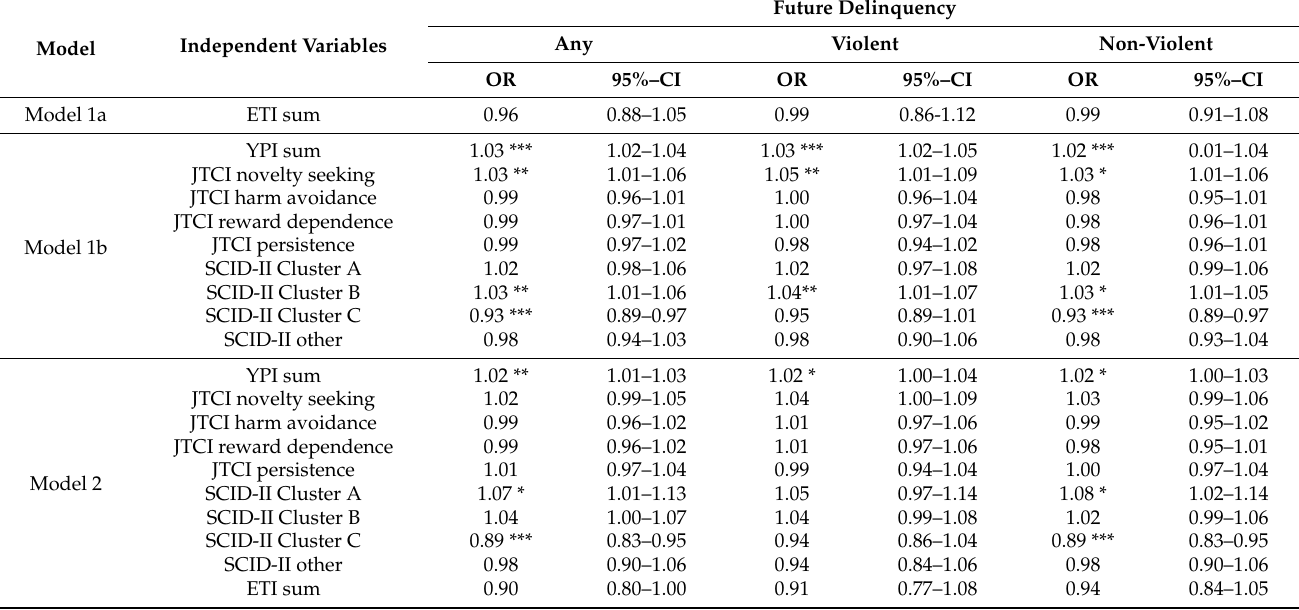
Table 4. Binary logistic regression analyses on future delinquency with ACEs, dimensional personality variables, and